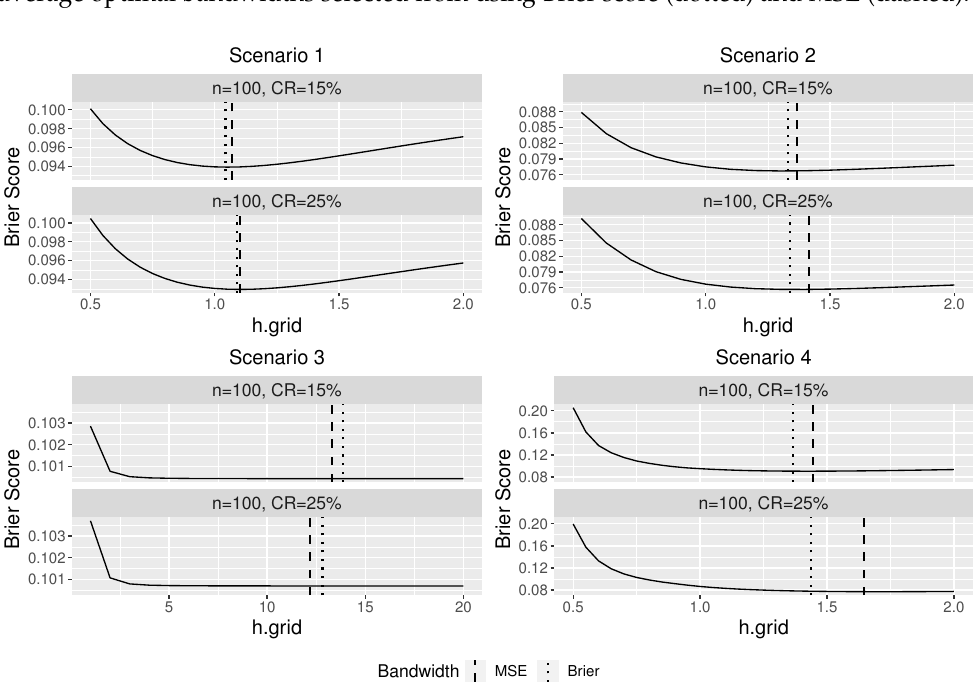
Figure 1. The average Brier score over 100 replications plotted against the grid of bandwidth for different scenarios. The vertical lines indicate the optimal bandwidth based on Brier scores and